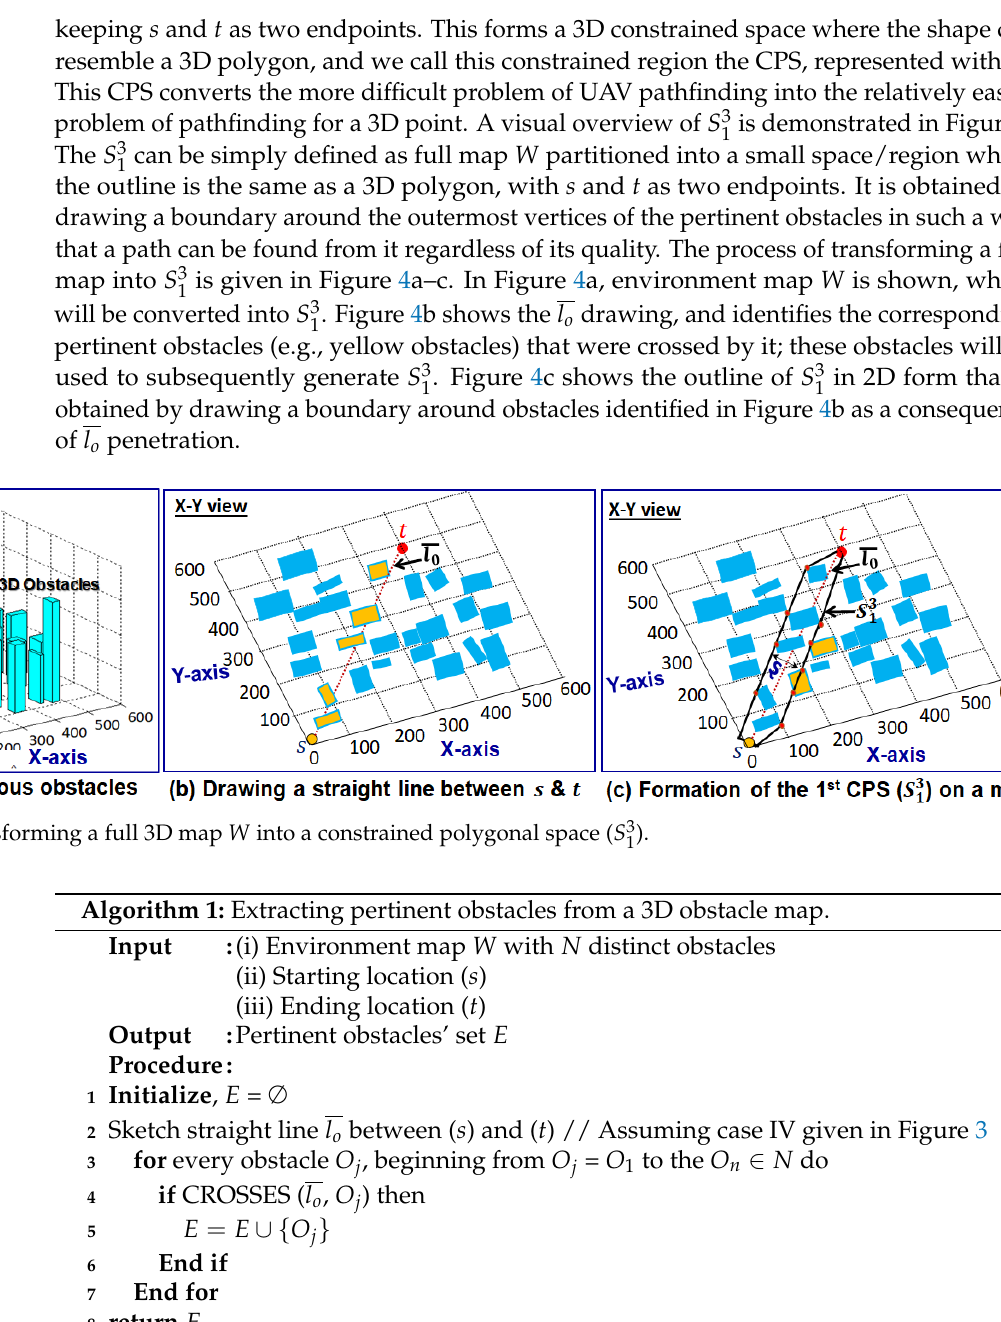
Algorithm 1: Extracting pertinent obstacles from a 3D obstacle